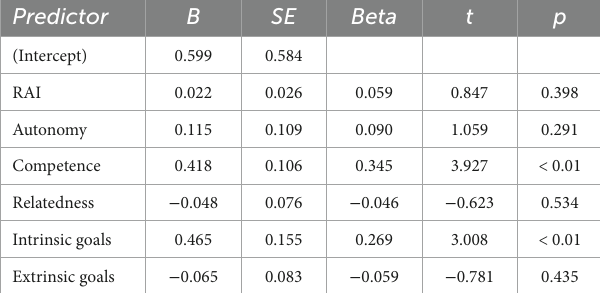
TABLE 3 Results of regression analysis predicting anticipatory sport persistence. Predictor